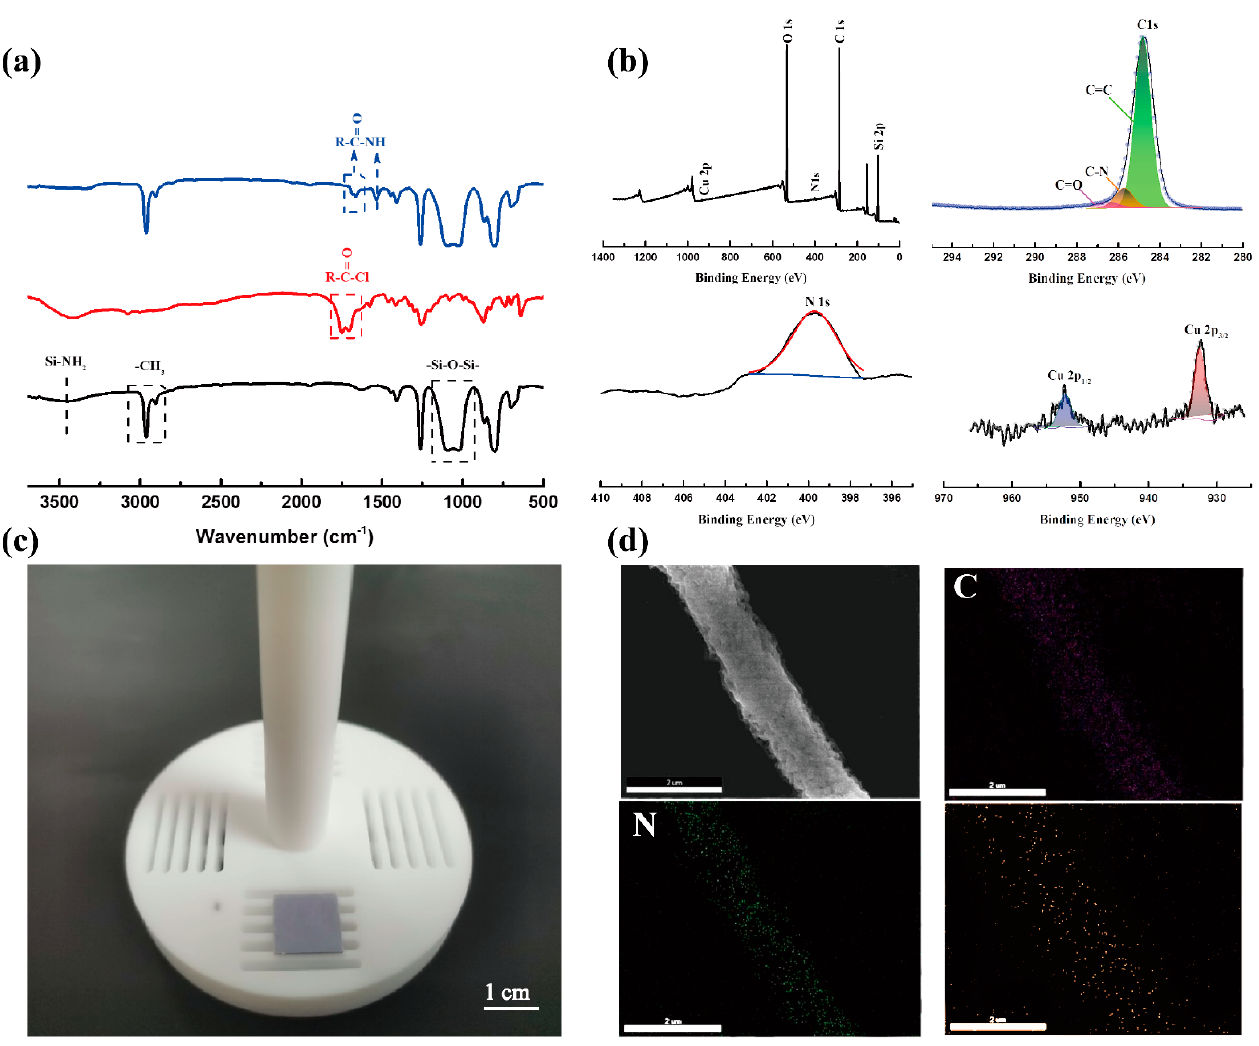
Figure 2. Characterization of PDMS-PCDA/Cu NFAs. ( a ) FT-IR of PDMS (black), PCDA (red), and PDMS-PCDA (blue). ( b ) XPS of PDMS-PCDA/Cu NFAs, focusing on N 1s, C 1s, and Cu 2p. ( c ) Photograph of the PDMS-PCDA/Cu fiber array on the (n ++ ) silicon wafer substrate. ( d ) SEM/EDX mapping images of PDMS-PCDA/Cu fiber.